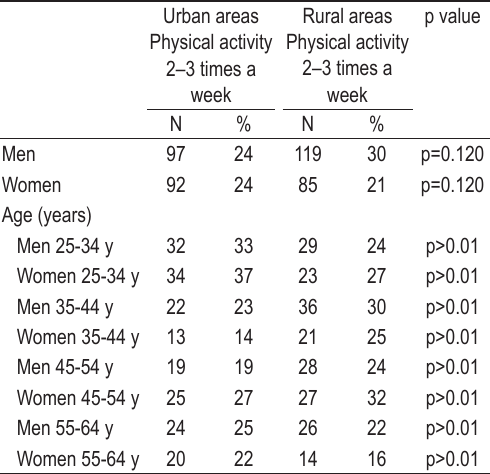
Table 3. Physical activity according to age and sex, urban/ rural